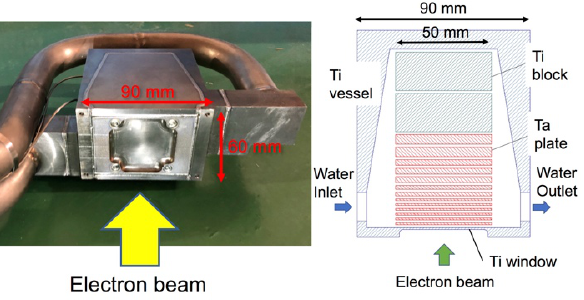
Fig. 5. Neutron production